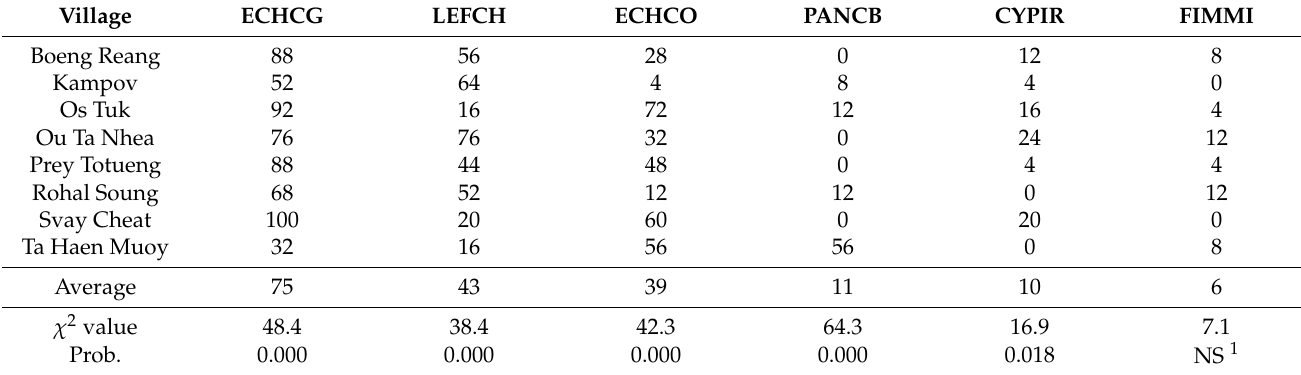
Table 7. Weed species that farmers consider to be becoming more problematic (% of